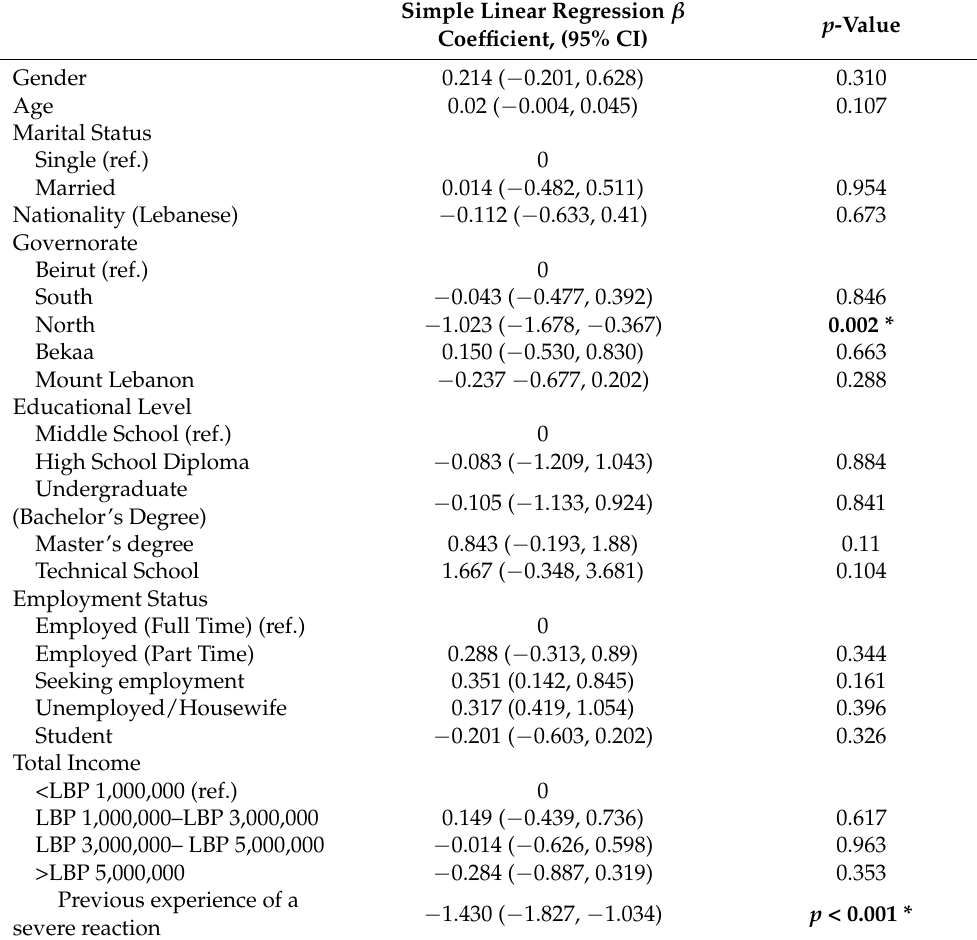
Table 6. Linear regression of food allergen knowledge scores with sociodemographic characteristics. Simple Linear Regression β